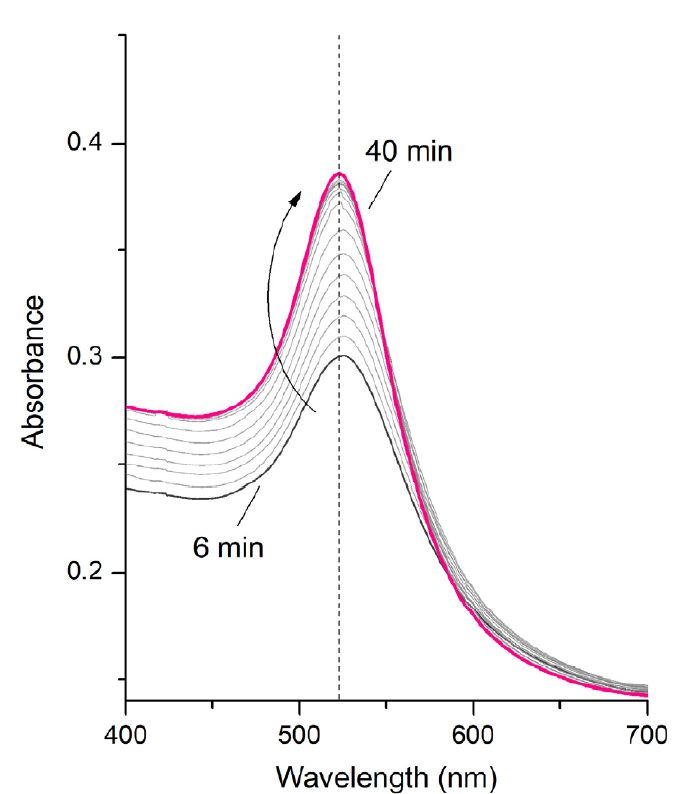
Figure 3. UV–VIS spectra showing the process of intermediate seed growth. The selected wavelength position at 523 nm is marked by a dotted line. The arrow indicates the time